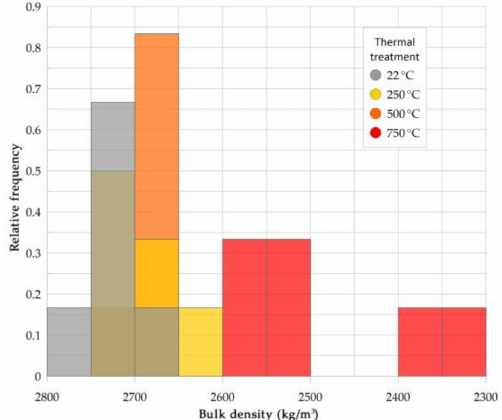
Figure 7. Histogram of bulk density